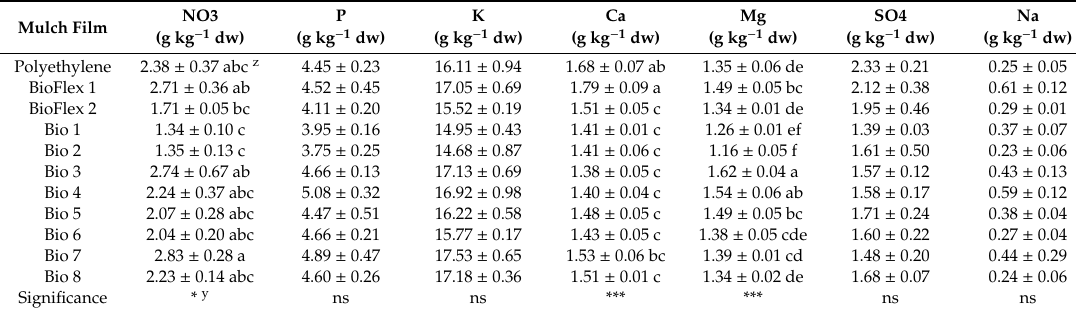
z All data are expressed as mean ± standard error, n = 3. Di ff erent letters within each column indicate significant di ff erences according to Duncan’s multiple-range test ( p ≤ 0.05). y ns, *, *** Non-significant or significant at p ≤ 0.05 and 0.001,